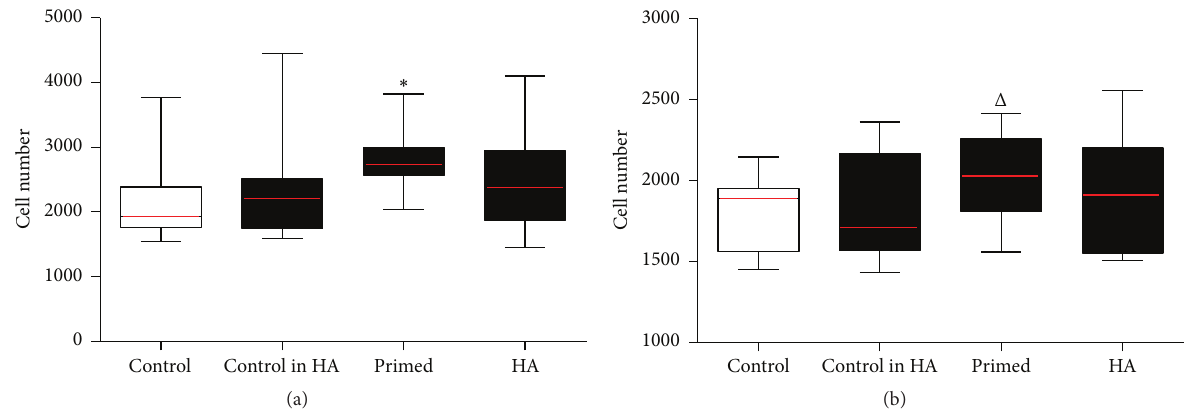
Figure 6: Treated MSCs seeded onto articular cartilage explants for 24 hours and three days. MSCs expanded until passage 2 in control media. On the third day flasks were treated with either control media or 1mg/mL HA media for another three days. Cells were then stripped and cell suspensions were counted using the standard enumeration technique. Cells were seeded into ultra-low adherence 96-well plates plugged with articular cartilage explants in the correct orientation. Conditions ( 𝑥 -axis) tested were cells grown in the control flask and seeded in control media (control) ( − − ), grown in control media and seeded in 1 mg/mL HA media (control in HA) ( − +), grown in 1mg/mL HA media and seeded in control media (primed) (+ − ), and grown in 1mg/mL HA media and seeded in 1 mg/mL HA media (HA) (+ +) and articular cartilage explants alone (no cells seeded to serve as a blank absorbance). Conditions were tested using five technical replicates per 96-well plate and run in biological triplicate ( 𝑛 = 3 ). Wells were assayed at the endpoint using Cell Counting Kit-8 and absorbance of the resulting media alone read at a wavelength of 450 nm ( 𝑦 -axis). All conditions were compared back to the control using a 𝑡 -test ( Δ = 0.19, ∗ 𝑝 value < 0.05). (a) MSCs seeded for 24 hours (adherence) into ultra-low adherence 96-well plates plugged with articular cartilage explants and (b) MSCs seeded for three days (proliferation) into ultra-low adherence 96-well plates plugged with articular cartilage